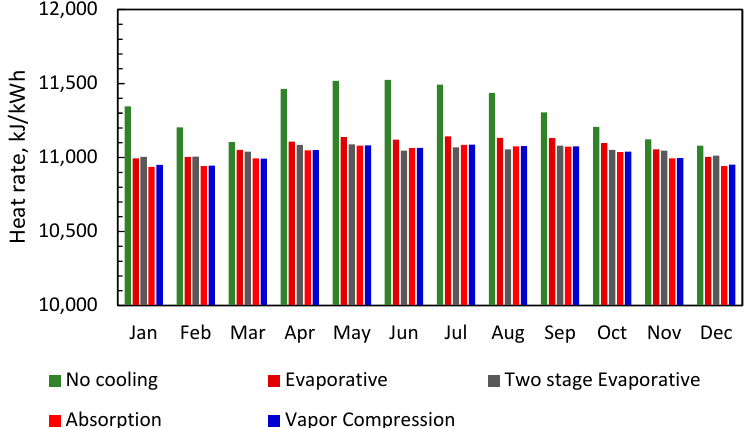
Figure 14. Effect of inlet cooling on turbine heat rate.